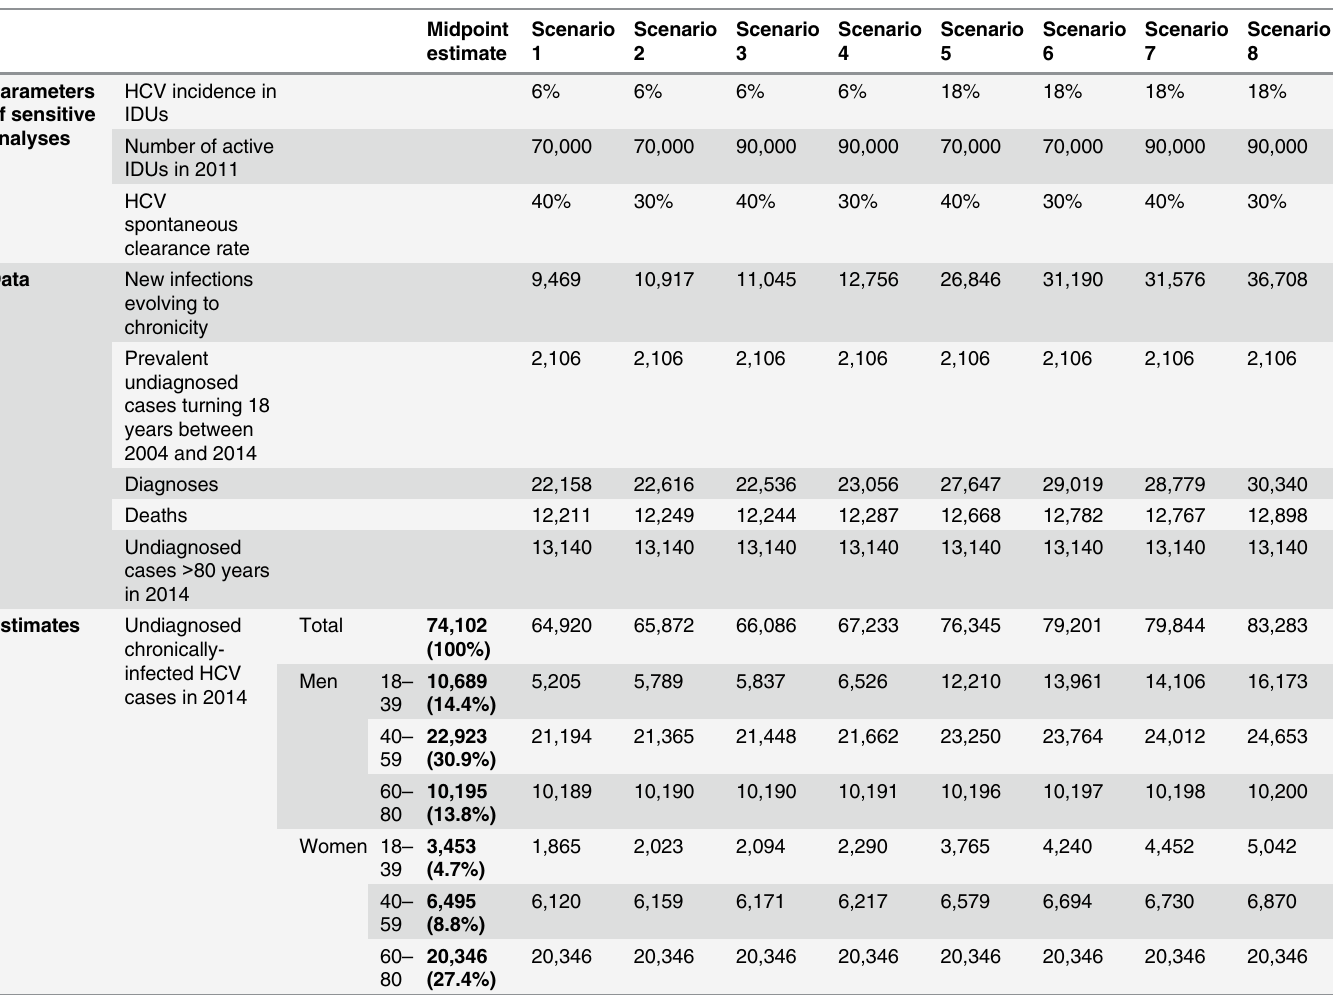
Table 2. Estimated numbers and distributions by gender and age-group of undiagnosed chronically-infected HCV population according to eight scenarios in 2014, mainland